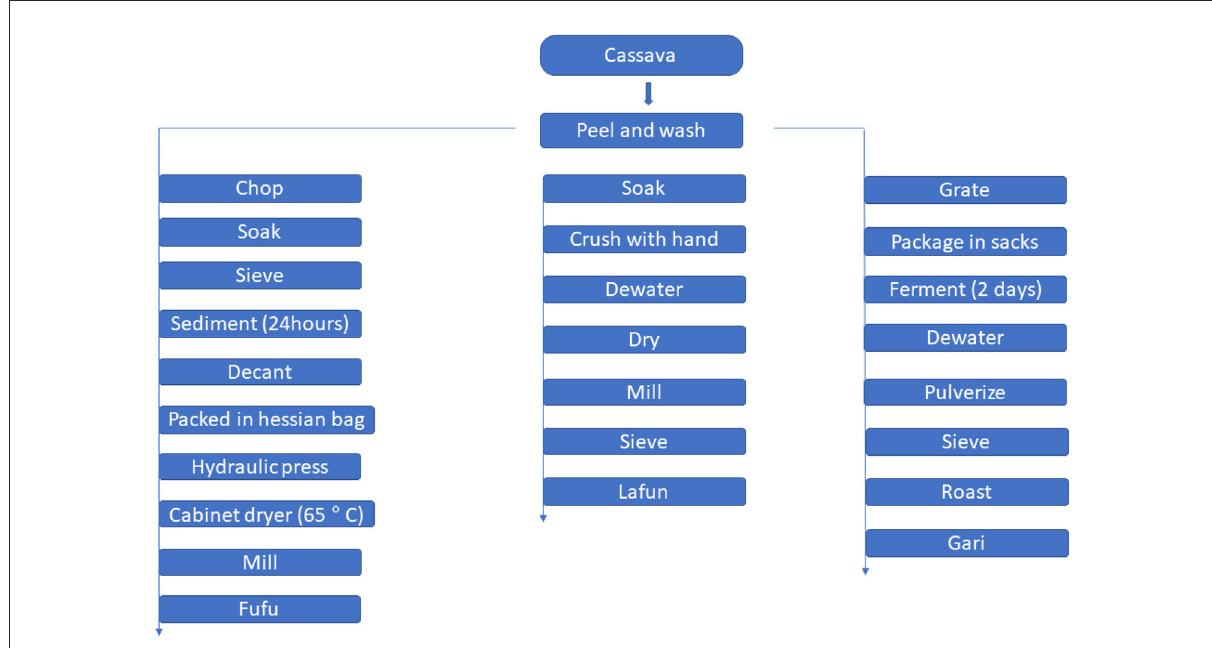
FIGURE1 A flow chart for traditional processing of cassava to gari, fufu and lafun